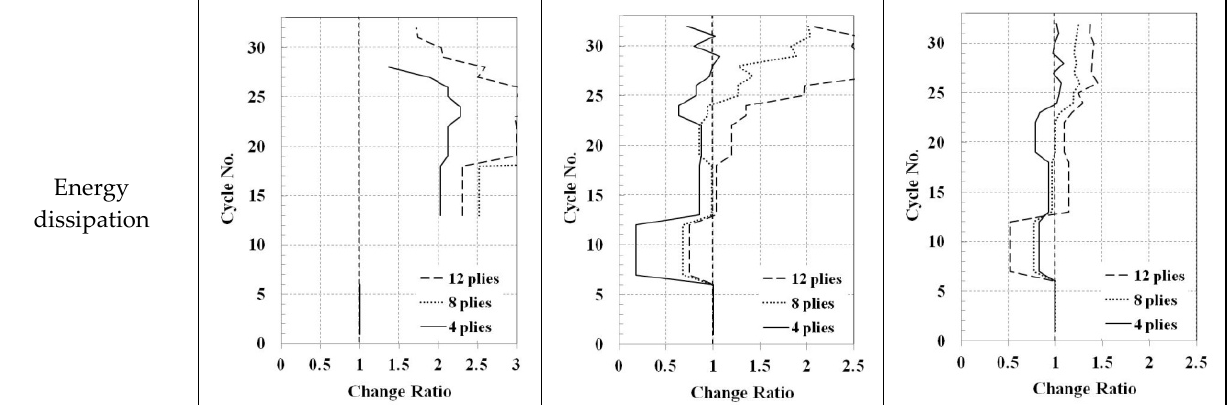
Figure 13. The load bearing capacity and the energy dissipation in each cycle of the cyclic loading for the chord and the brace-retrofitted joints. The values are normalized with respect to the corresponding values of the non-retrofitted case.